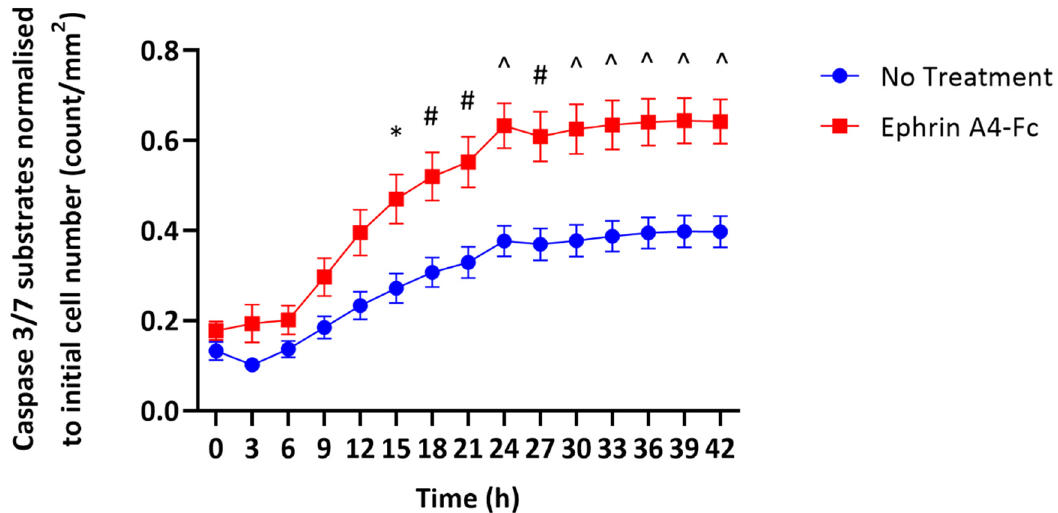
Figure 3. Treatment with the EphA4 ligand, ephrin A4-Fc results in increased cell death in iPSC-derived motor neurons from a SOD1 E101G MND patient. IPSC-derived motor neurons from a SOD1 E101G MND patient were matured for four weeks under hypoxic conditions (3% oxygen) and then transferred to a normoxic incubator (21% oxygen) for 42 h, with or without the EphA4 ligand ephrin A4-Fc (10 µg/mL). Apoptosis was assessed by quantifying the number of caspase 3/7 substrates every 3 h using an Incucyte. Two-way ANOVA revealed that there were significant main effects of time (F(14.112) = 219.2, p < 0.0001), treatment (F(1.8) = 11.86, p = 0.0088), and time × treatment interaction (F(14.112) = 14.46, p < 0.0001). Sidak’s test for multiple comparisons showed that iPSC-derived motor neurons from the SOD1E101G MND patient treated with ephrin A4-Fc showed a significant increase in the number of caspase 3/7 substrates per mm 2 from 15 h onwards compared to motor neurons without treatment. Data presented as mean ± SEM of n = 5 technical replicates; * p < 0.05; # p < 0.01; ^ p < 0.001.